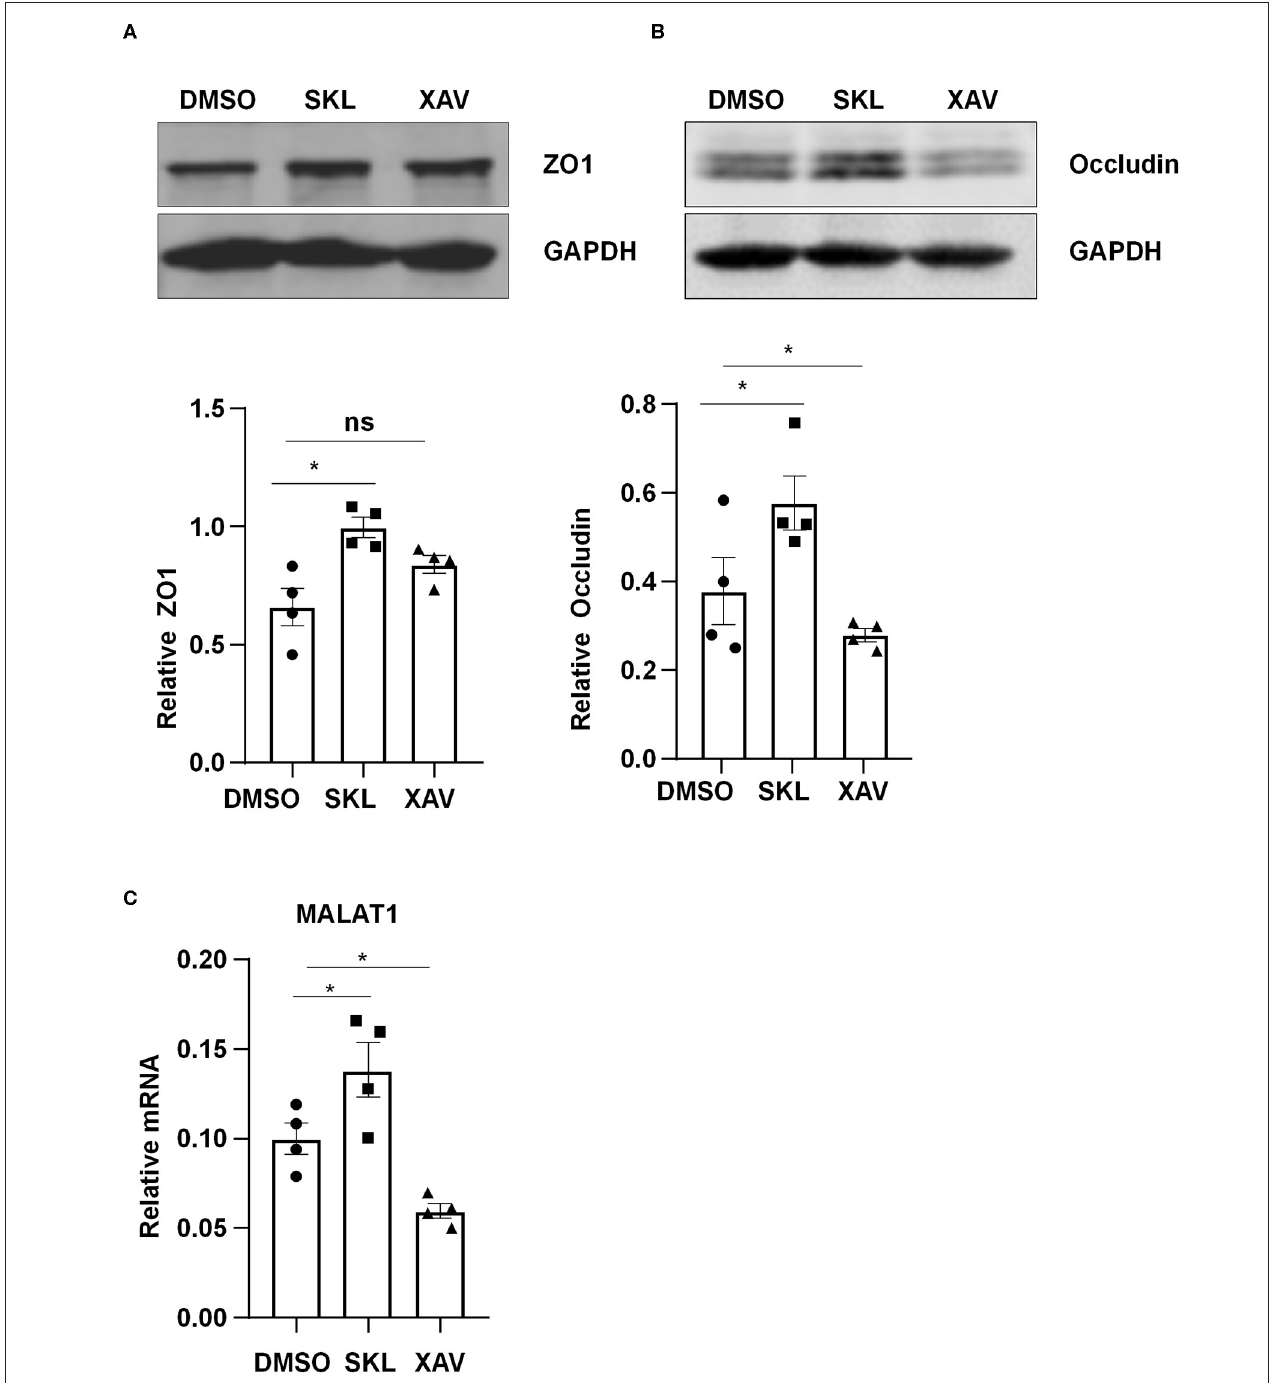
FIGURE 6 | Agonist or inhibitor of the Wnt/ β -catenin pathway regulate the expressions of MALAT1, ZO1, and Occludin. HUVECs were incubated with SKL2001 (30 µ mol/L) and XAV939 (20 µ mol/L) for 12h, and the expressions of ZO1, Occludin, and MALAT1 were analyzed by Western blot (A,B) or qRT-PCR (C). In (A,B) , semi-quantification of the blots are shown in the lower panels. Statistical analysis of (A–C) were performed by One-way ANOVA. * P < 0.05 compared with the indicated controls.